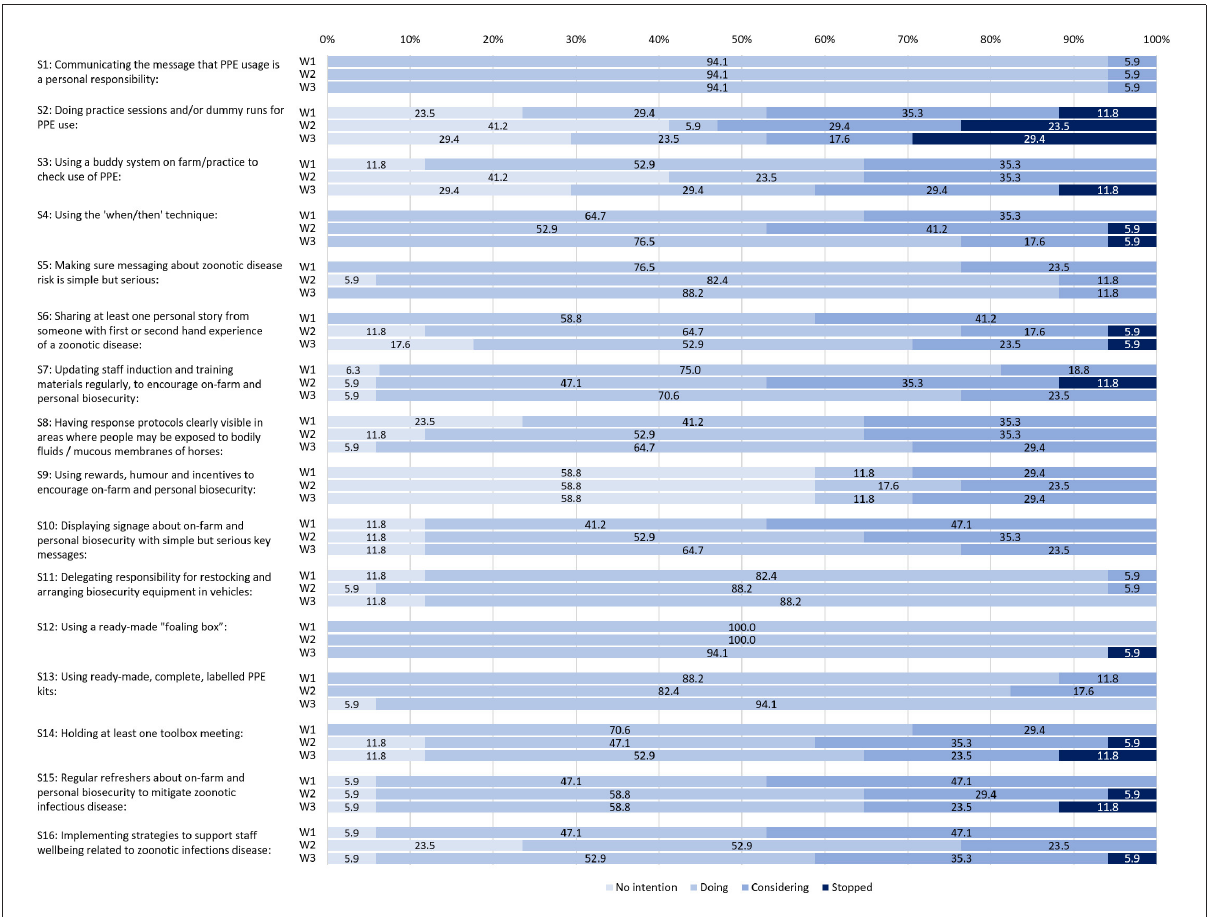
FIGURE1 The percentage of participants at different stages of strategy adoption, disaggregated across three self-audit survey